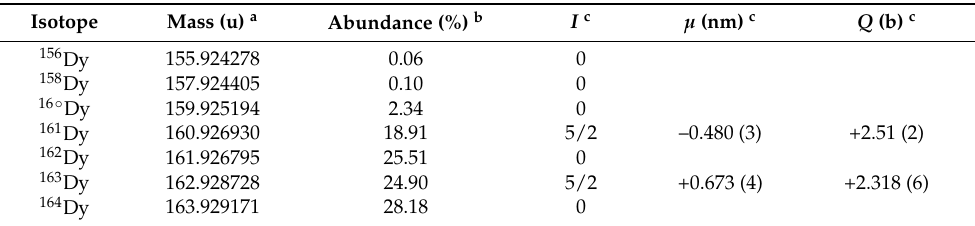
Table 1. Properties of the Dy isotopes. I , µ , and Q are the nuclear spin, magnetic dipole moment, and electric quadrupole moment, respectively. Isotope Mass (u) a Abundance (%) b I c µ (nm) c Q (b)